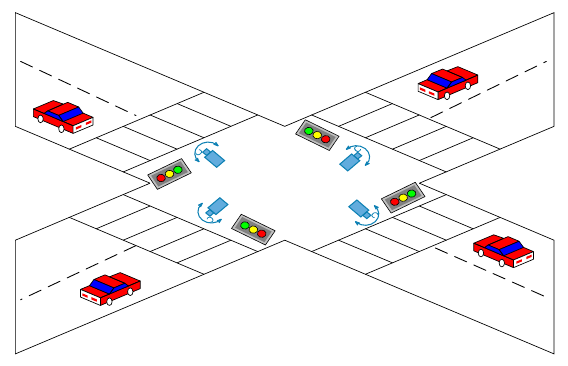
Figure 3. A schematic diagram for the camera erection.